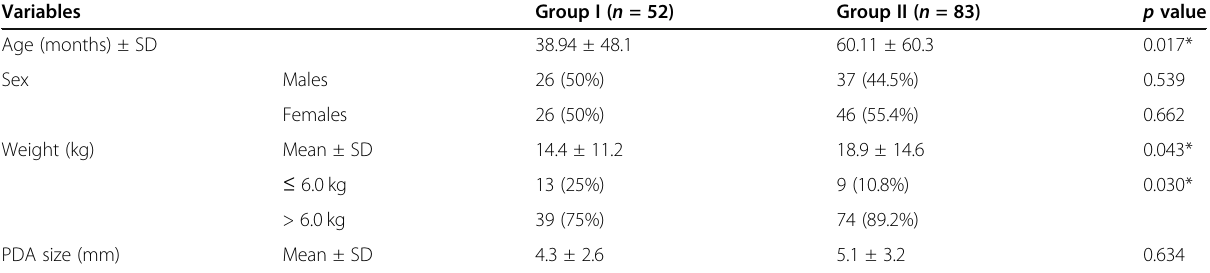
Table 1 Baseline characteristics in the two groups of children with PDA device closure Variables